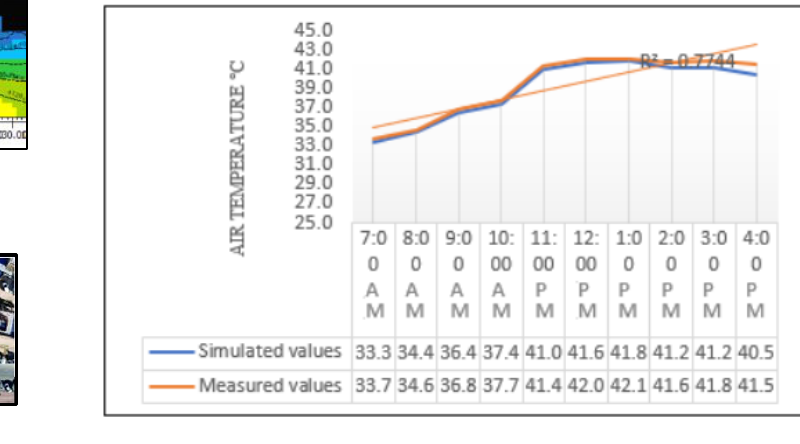
Figure 5. Validation results for the software simulation. ( a ) The chosen point (A) for the validation; ( b ) The chosen point (A) for the validation in the heritage area; ( c ) Graph for both air temperature recordings: simulated by ENVI-met and measured by Extech 45170.